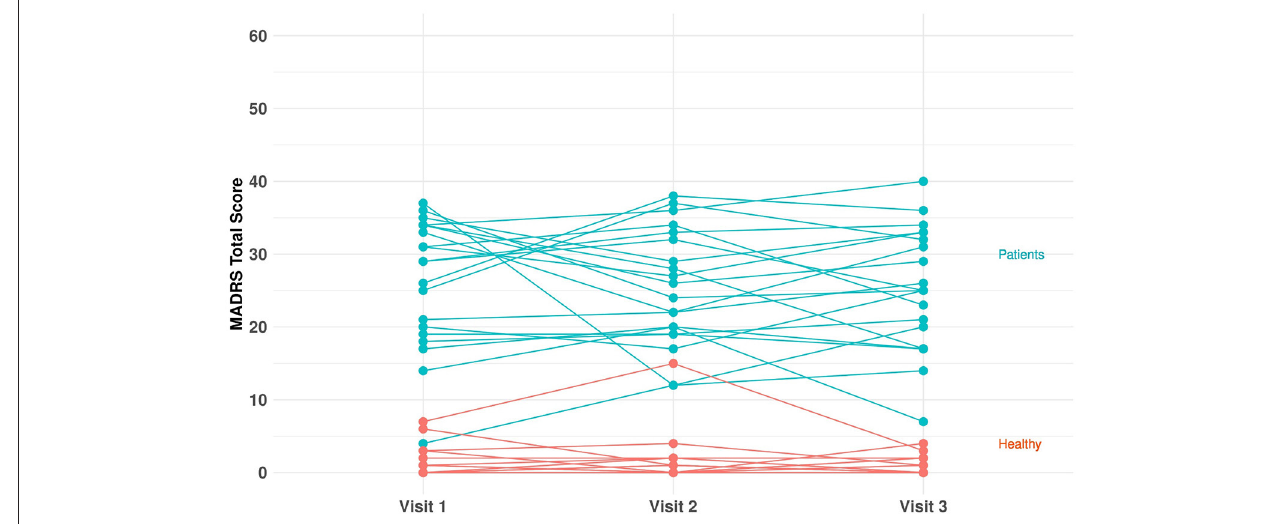
FIGURE 2 | MADRS total score per group (healthy and unipolar depression) and per visit.